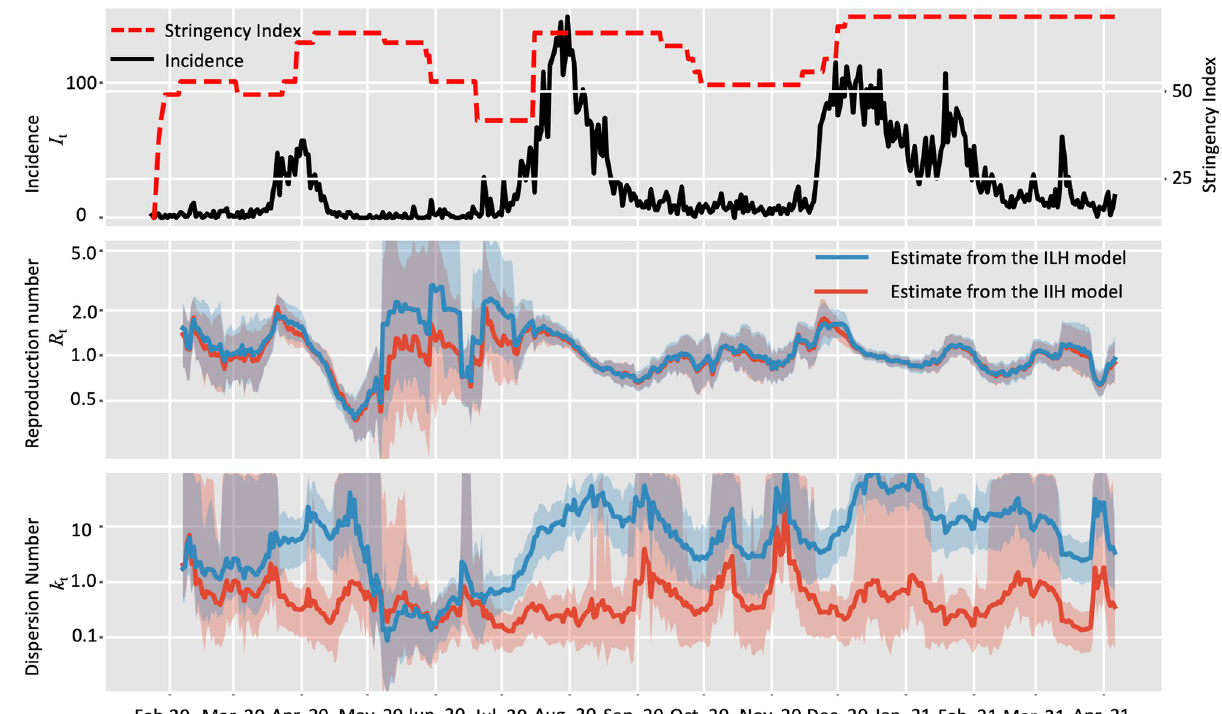
Fig 5. Comparison of estimating real-time transmission dynamics of the COVID-19 epidemic between Jan 23, 2020 and Apri 5, 2021, in Hongkong, China. Transmission dynamics (i.e., reproduction number R and dispersion number k ) were assumed constant over a window of 14 days, and the estimates were obtained by analyzing the incidence data of the time window. Solid lines show the mean estimates from two methods. Red curves and blue curves represent the estimation from the instant-individual heterogeneity model (IIH) and the instant-level heterogeneity (ILH) model respectively. The shaded areas show the 95% high probability density (HPD) intervals. A: Incidence data of the confirmed cases and government ); C: Estimation of dispersion number ( k ). stringency data in South Africa; B: Estimation of reproduction number ( R t t